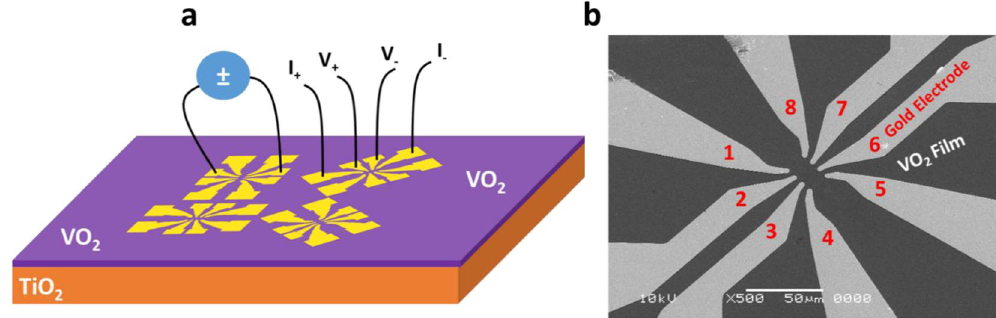
Figure 1. ( a ) Schematic of the device structure, representing a VO 2 film grown on a TiO 2 substrate, Au electrodes structured by photolithography, and the measurement geometry in two-probe and four probe configurations. ( b ) Corresponding scanning electron microscope image of these devices, showing the Au electrodes. The separation between contacts 1, 2, 3, 4 or 5, 6, 7, 8 is 3 µ m, while these sets of contact are separated from each other by about 12 µ m.